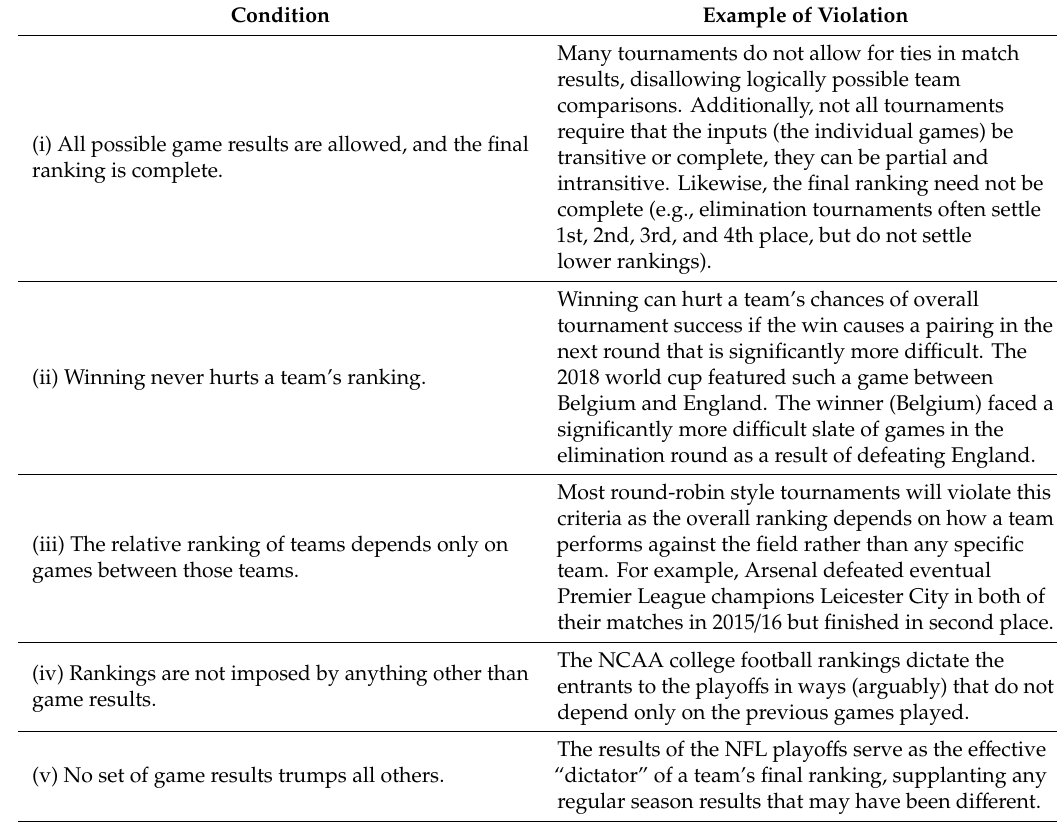
Table 5. Arrow’s conditions and sports